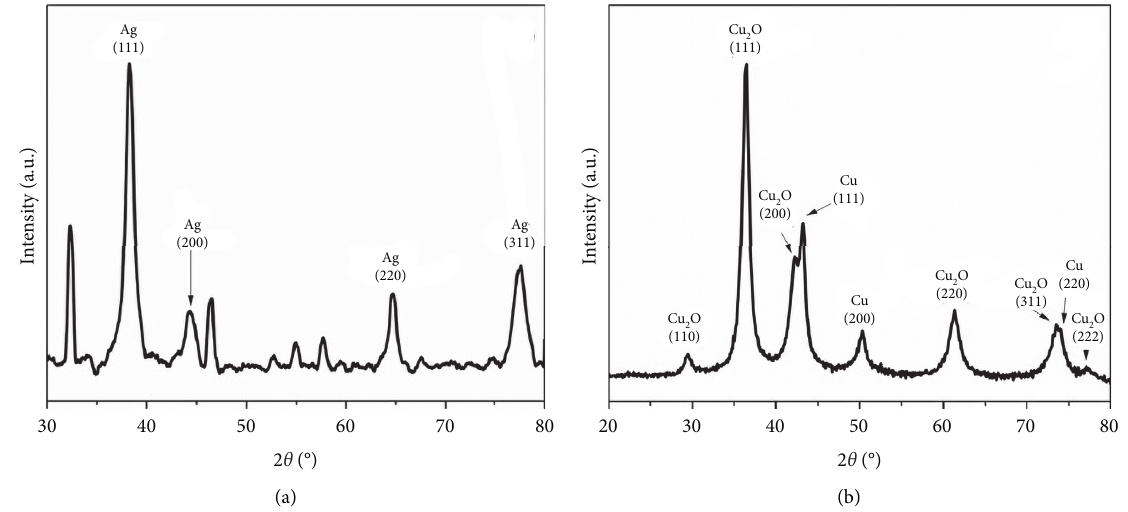
Figure 5: XRD pattern of nanoparticles. (a) silver nanoparticles and (b) copper